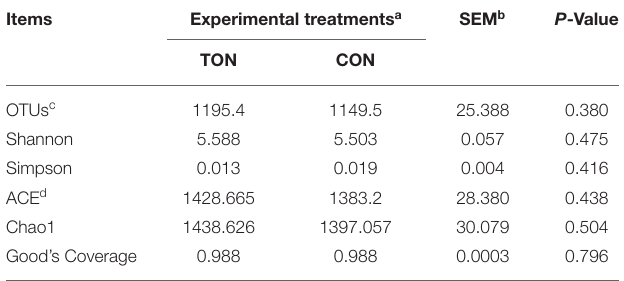
TABLE 5 | Comparison of differences in blood physiological and biochemical indices in dairy cows showing tongue- rolling behavior or no signs of abnormal